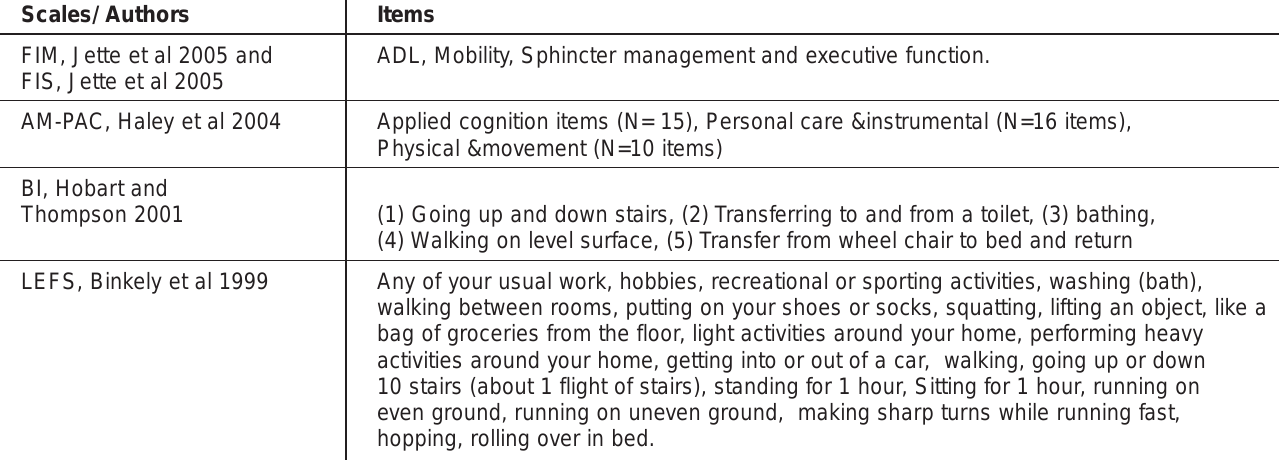
Table 2: Summary of functional items listed in eligible papers Scales/